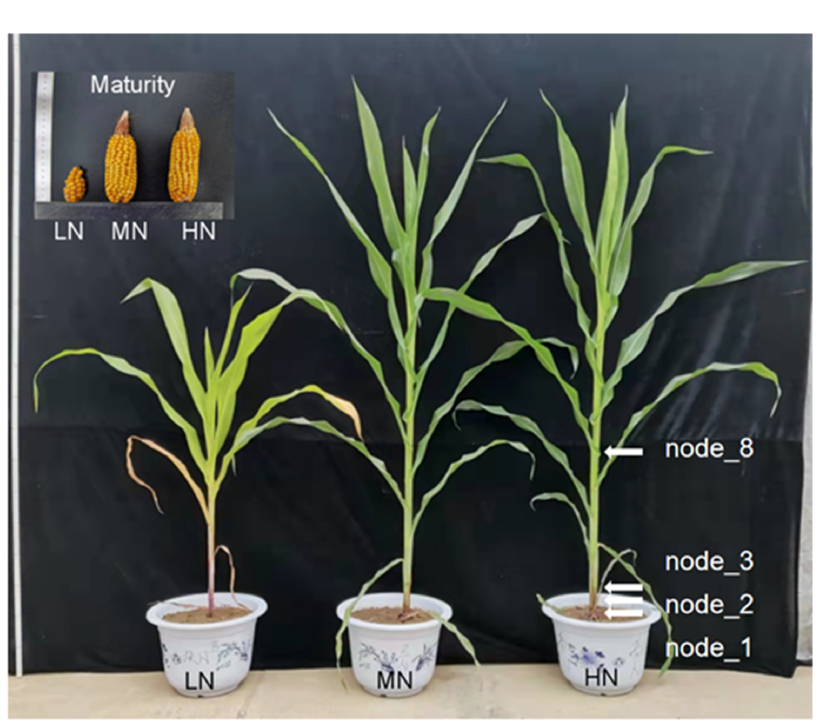
Figure 1. Phenotypes of maize plant at 62 days after sowing and ears at maturity under low to high nitrogen supply. LN, no nitrogen application; MN, 0.15 g N kg − 1 ; HN, 0.30 g N kg − 1 ; Arrows indicate the stem node position.